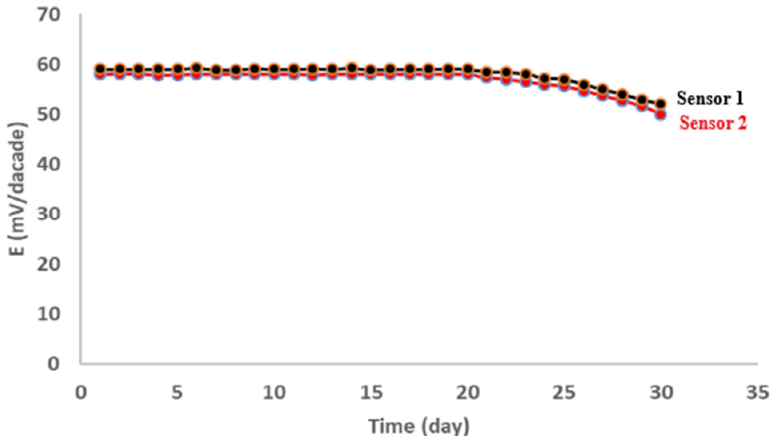
Figure 5. Stability of the MOX membrane sensors.